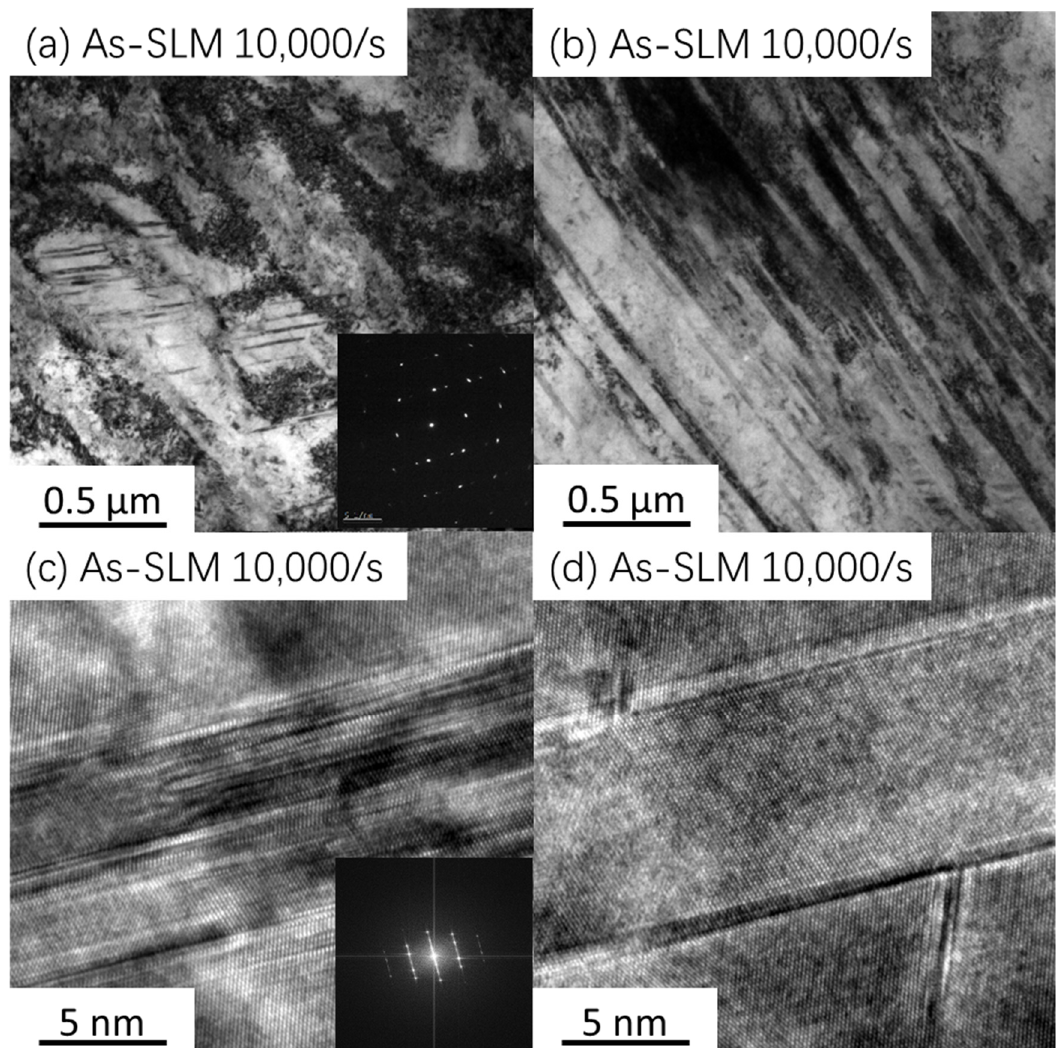
Figure 8. TEM images of the As-SLM specimen deformed at 10,000/s. ( a ) Elongated dislocation cell structures and abundant nanotwins. ( b ) Microbands with average spacing of 70 nm. ( c ) High resolution TEM near the dislocation cell wall. ( d ) High resolution TEM shows the existence of secondary twins.